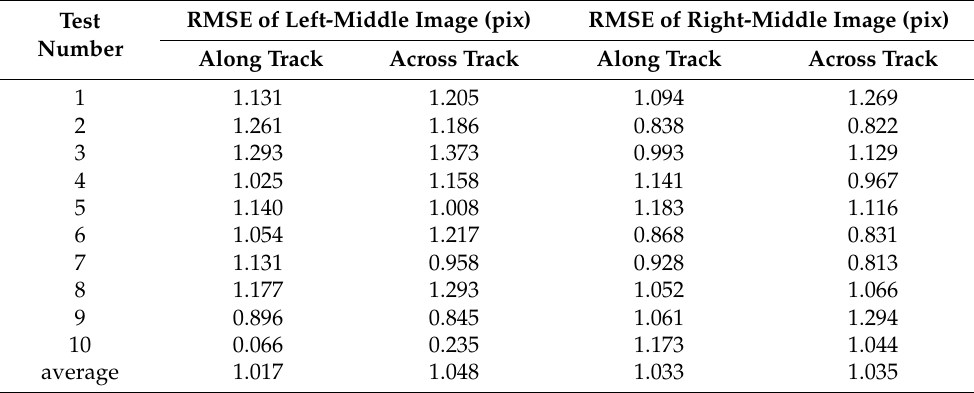
Table 20. Relative orientation residual for different initial value.